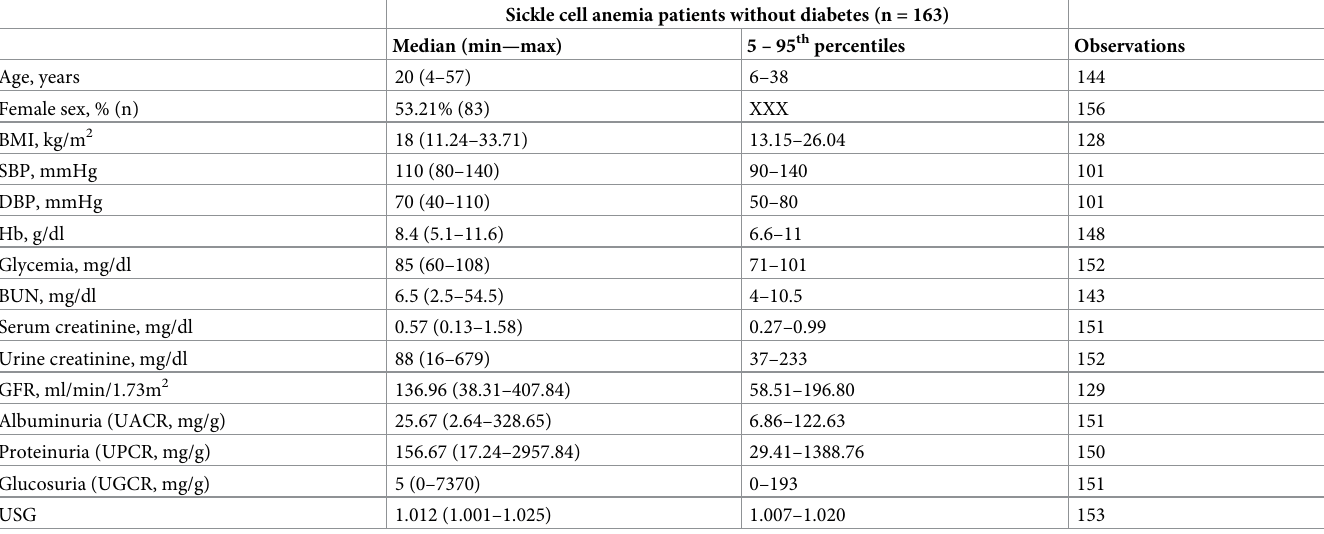
Table 2. Description of anthropometric and biochemical parameters of sickle cell anemia patients.